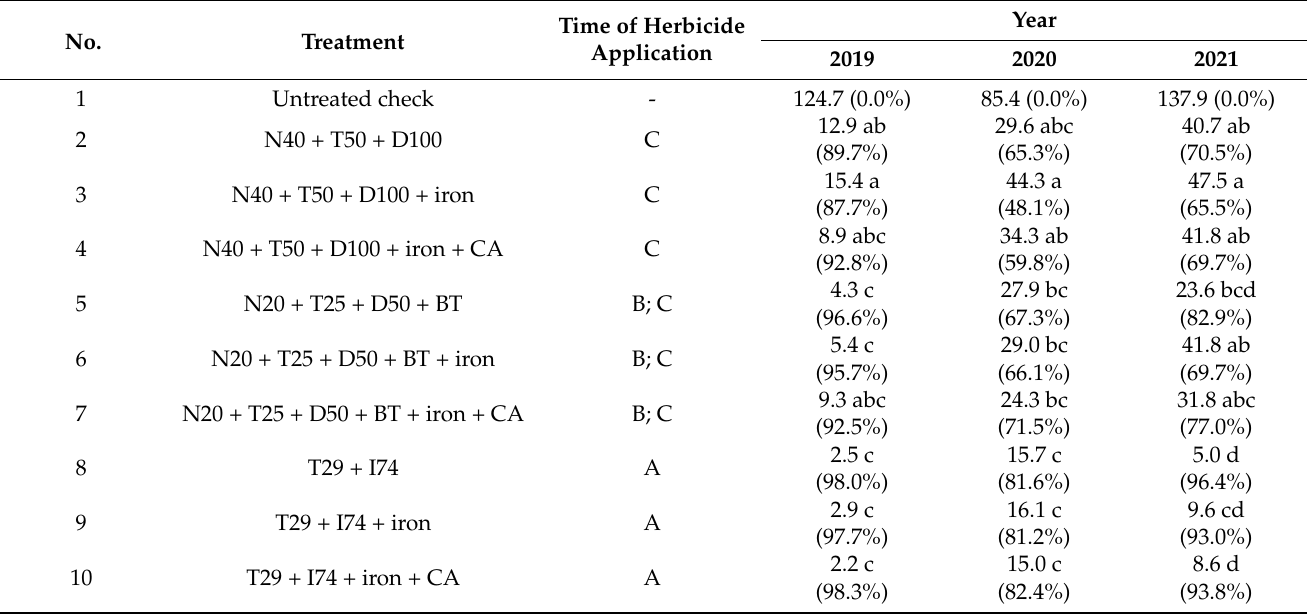
Table 5. Number of weeds per m 2 and percentage of their reduction compared to control (untreated check) [%].